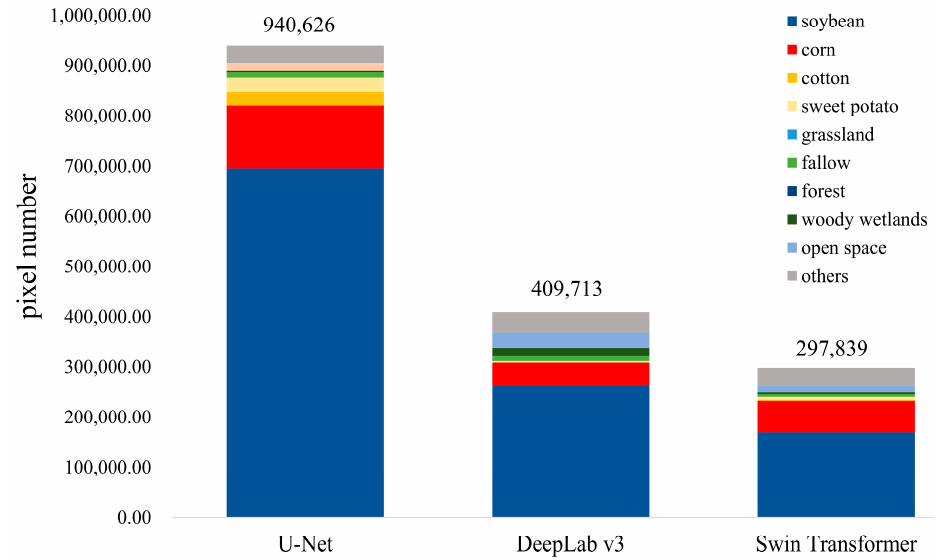
less misidentified by all the three networks. Figure 10. Percentage of each land use type in the prediction images. Figure 10. Percentage of each land use type in the prediction images.